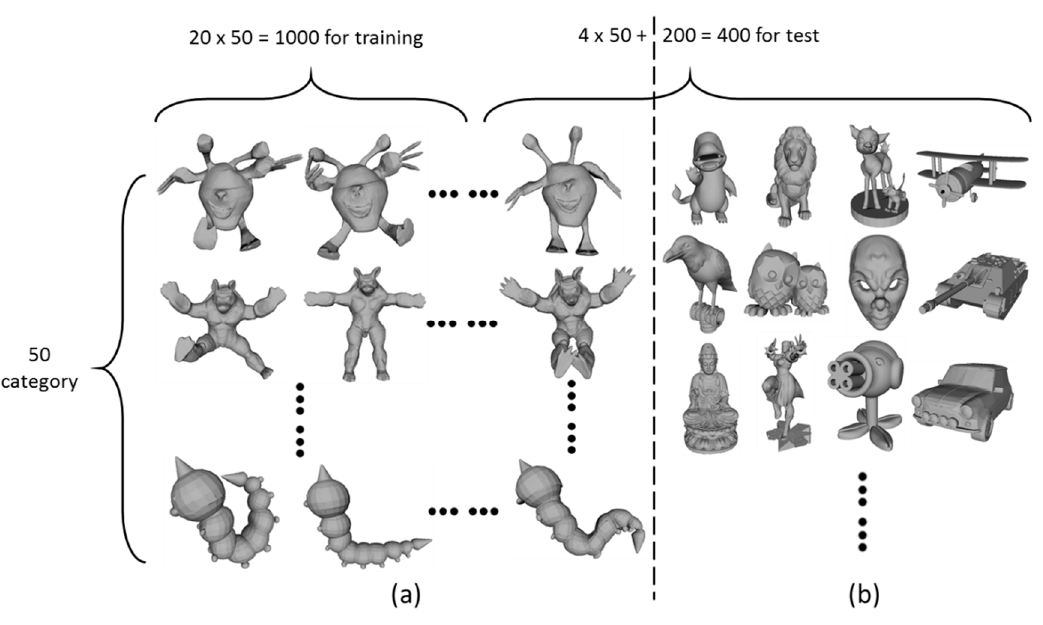
Figure 3. Examples of 3D models used in our identification experiments. ( a ) Examples of 3D models in the SHREC’15 Non-Rigid 3D Shape Retrieval ; ( b ) Examples of 200 extra 3D models collected from Thingiverse